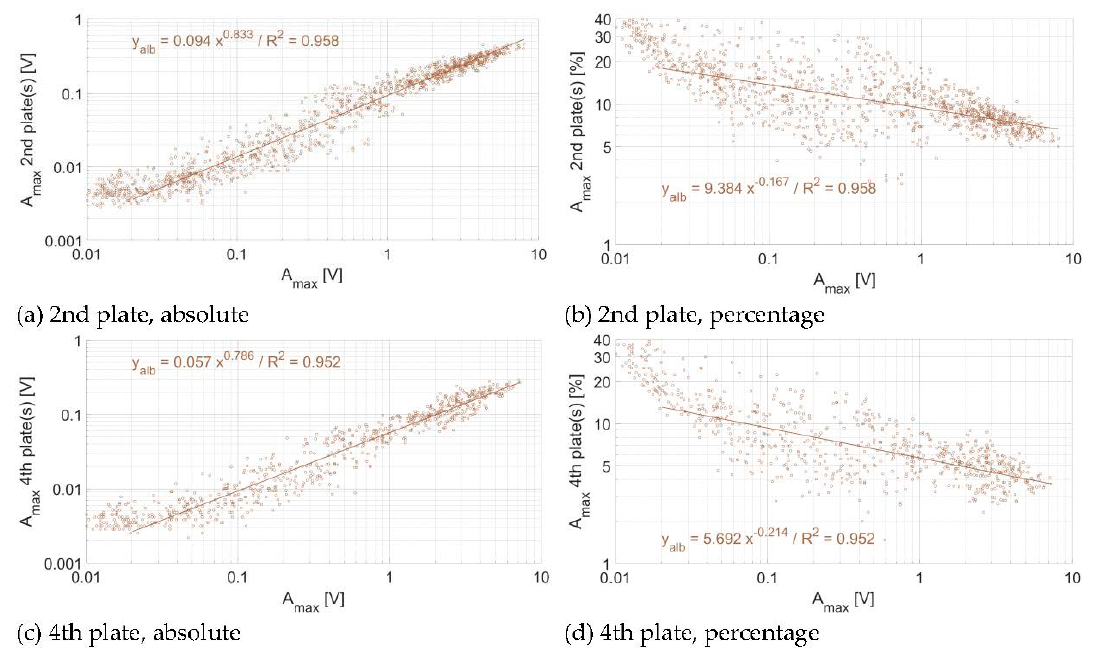
Figure 8. Energy propagation across plates at the Albula measuring station ( a , b ) at two plates of distance and ( c , d ) at four plates of distance, in absolute (left column) and relative (right column) numbers. Each dot represents the voltage associated to a single impact. The regression is fitted only for A max greater than 0.02 V. Table 6. A max required for the 0.1 V threshold to be exceeded at one, two, three, and four plates of distance in all three investigated measuring